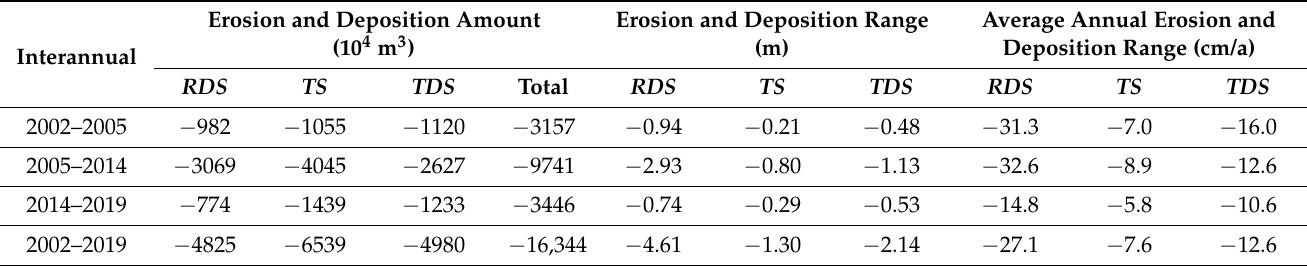
Figure 6. The proportion of erosion area and deposition area at each time period. Table 1. Statistics of net erosion and deposition of Oujiang Estuary from 2002 to 2019.